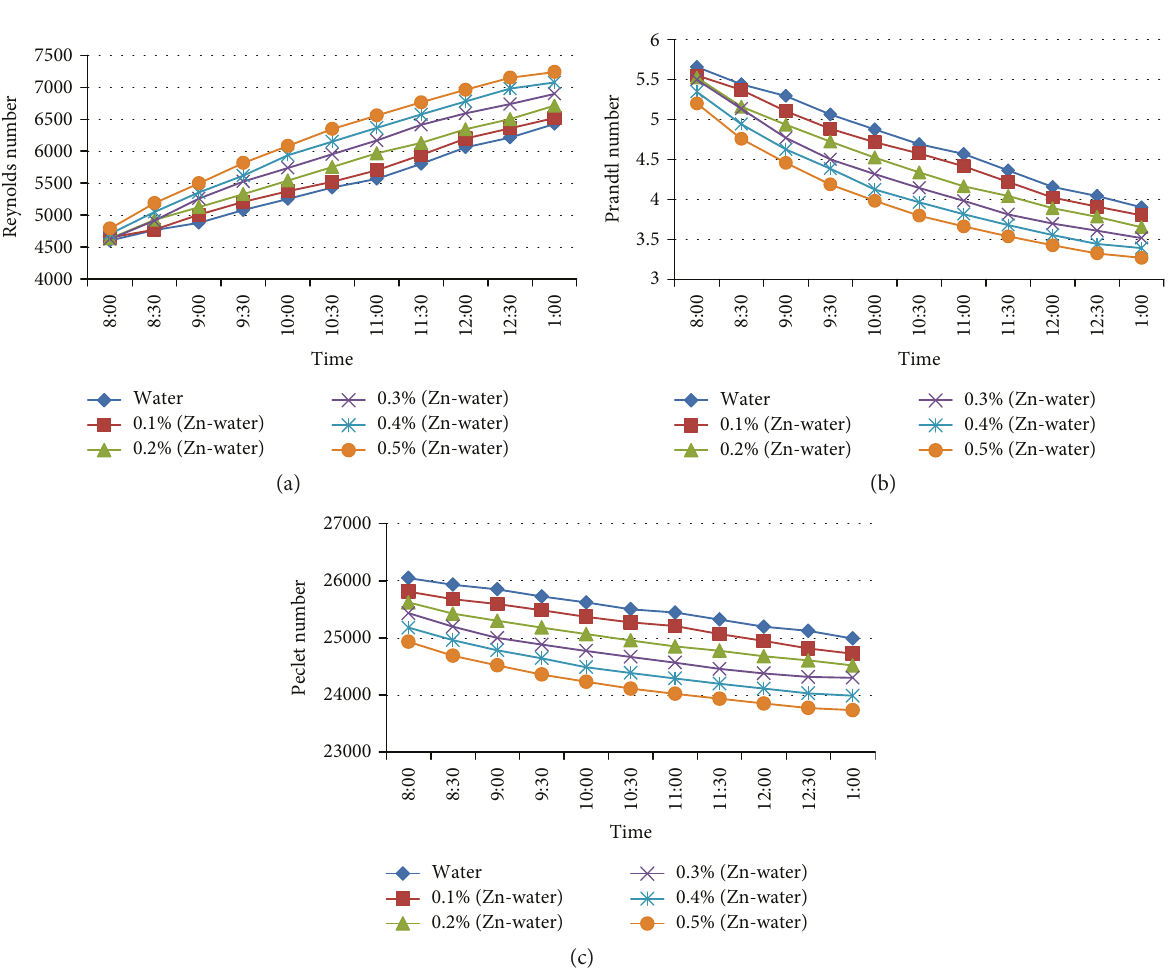
Figure 12: E ff ect of Zn-H O nano fl uid at 2L/min on (a) Reynolds number, (b) Prandtl number, and (c) Peclet 2